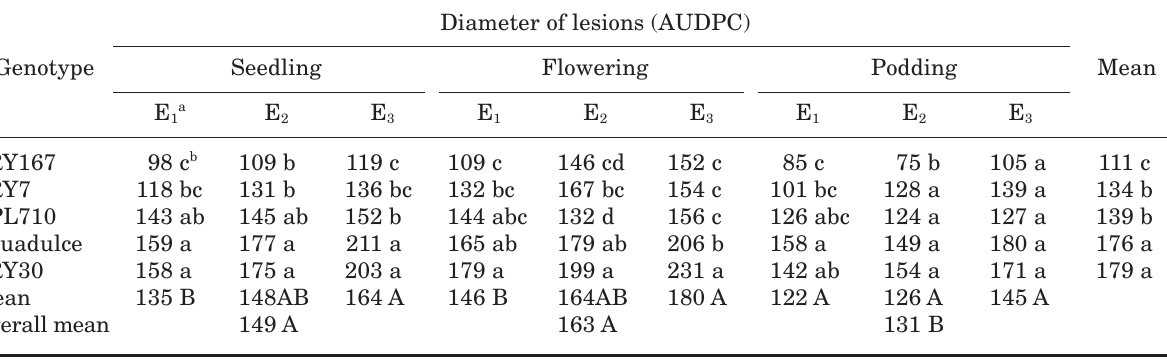
Table 1. Effect of growth stage and leaf age on chocolate spot severity expressed as the area under disease progress curve (AUDPC) values of lesion diameter in leaflets of five faba bean genotypes inoculated with Botrytis fabae. Diameter of lesions